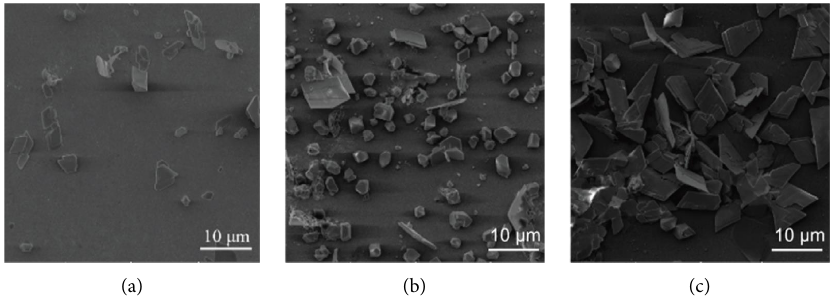
Figure 5: SEM micrographs of Pb deposits on FTO substrate at diferent temperatures. (a) T � 5 ° C, (b) T � 20 ° C, and (c) T � 35 ° C.